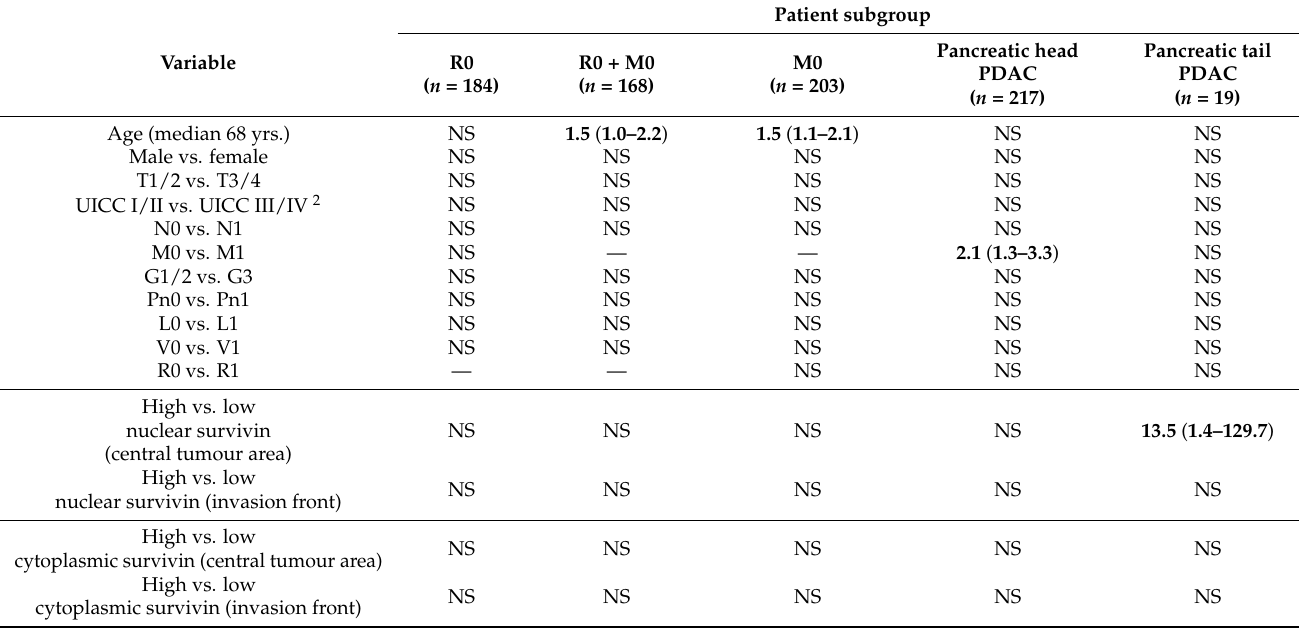
Table 6. Multivariate subgroup analysis for overall survival 1 .